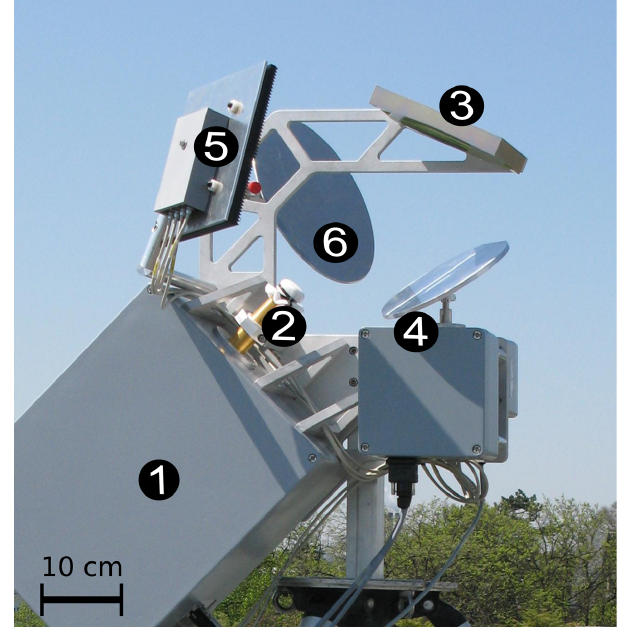
Fig. 4. WIRA’s frontend and optics. 1: Frontend case, 2: Horn an- tenna, 3: Parabolic reflector, 4: Slewable plane mirror and driv- ing motor, 5: Ambient temperature calibration load, 6: Plane zenith/nadir mirror for